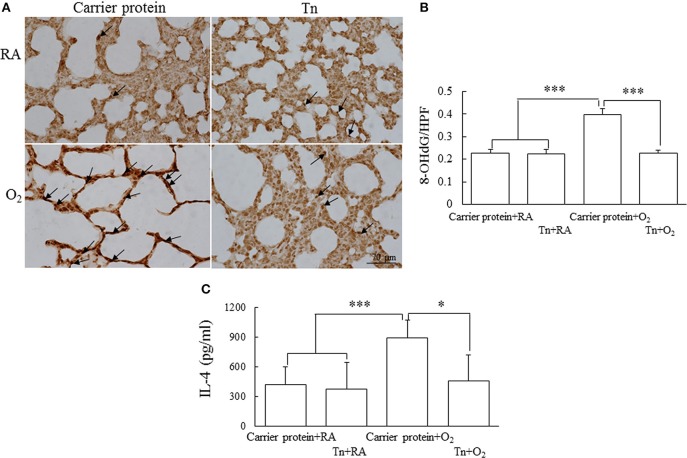
(A) Representative immunohistochemistry of 8-hydroxy-2′-deoxyguanosine (8-OHdG), (B) quantitative analysis of 8-OHdG-positive cells, and (C) lung IL-4 in 14-day-old rats in the carrier protein + RA, Tn vaccine + RA, carrier protein + O2, or Tn vaccine + O2 group. Positive staining is indicated in brown (arrow). The rats in the carrier protein + O2 group exhibited a significantly higher number of positive 8-OHdG cells and IL-4 levels than those in the carrier protein + RA or Tn vaccine + RA group. Maternal Tn immunization significantly decreased the hyperoxia-induced increase in the number of positive 8-OHdG cells and IL-4 levels. *p < 0.05, ***p < 0.001.